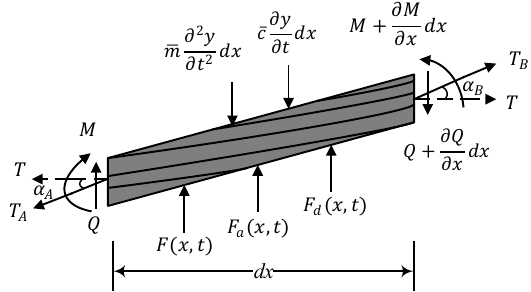
Figure 4. The transmission line element diagram.